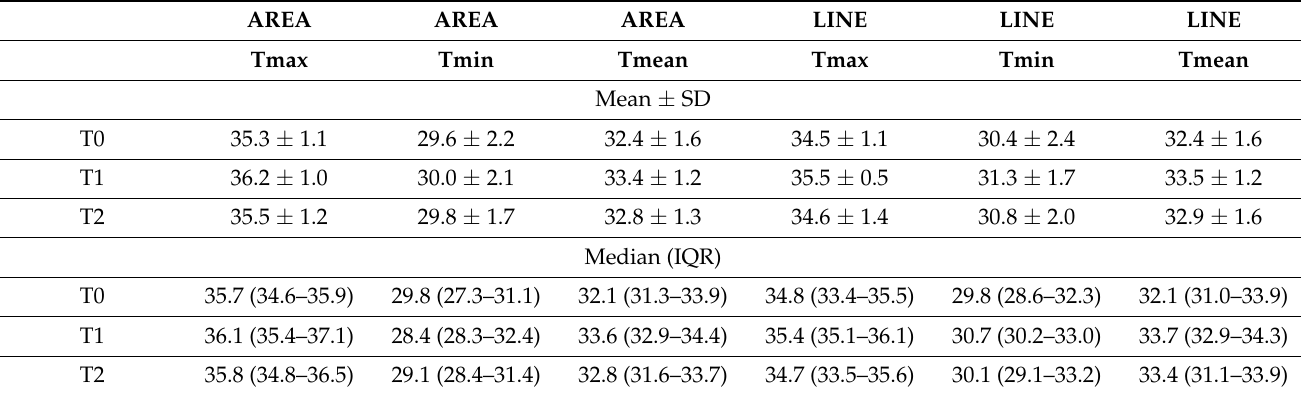
Table 2. Mean ± SD and Median and Interquartile Range (IQR) of maximum, minimum and mean temperature values in the areas and the lines at T0, T1 and T2. All values are expressed in ◦ C.